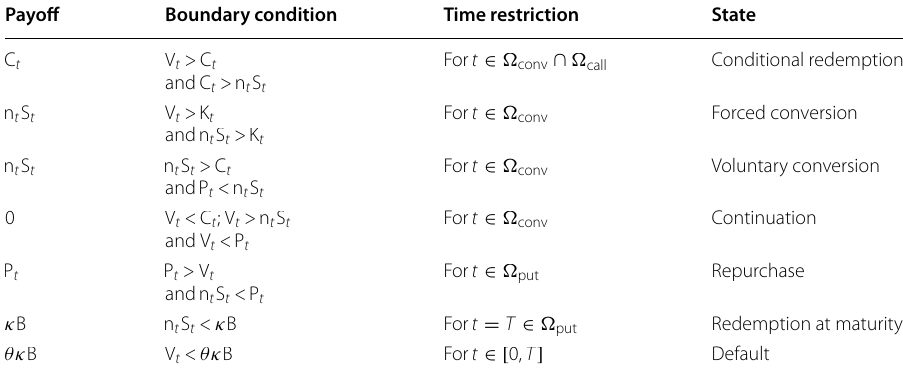
Table 1 Payoff structure of convertible bonds